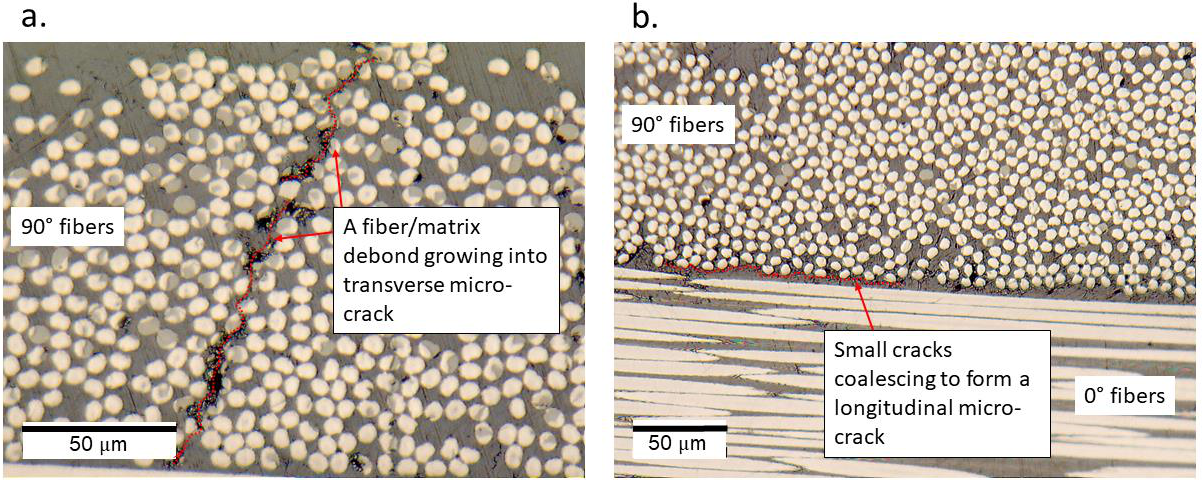
Figure 11. ( a ) Transverse microcrack, and ( b ) longitudinal microcracks in the specimen that was tested at a cyclic amplitude of 40 μ m and a pause time of 1 s.